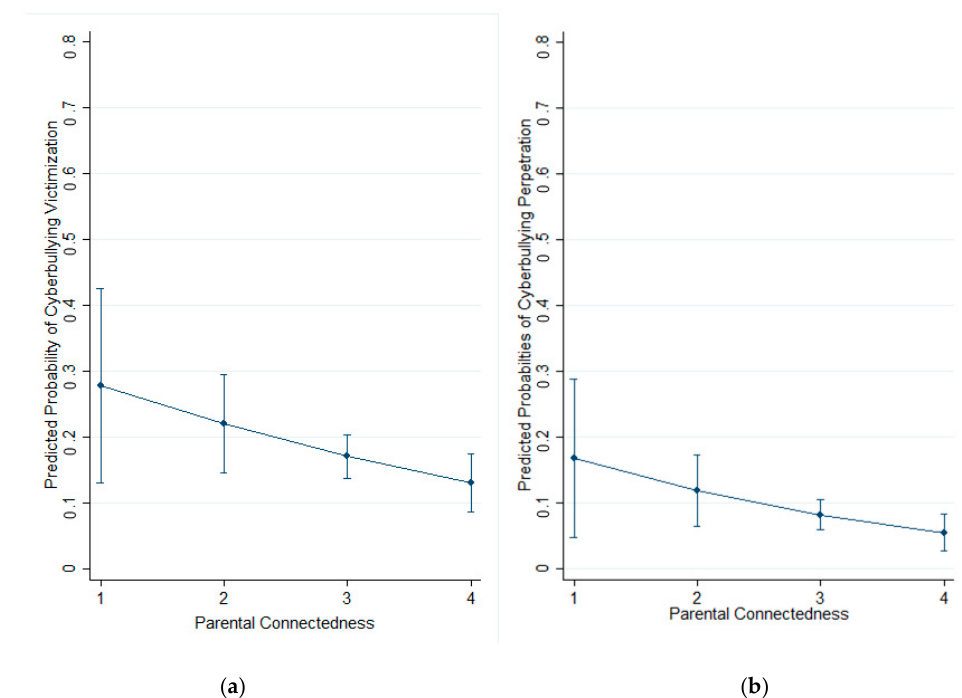
Figure 1. Marginal effects of parental connectedness on the predicted probabilities of ( a ) cyberbullying victimization and ( b ) cyberbullying perpetration.